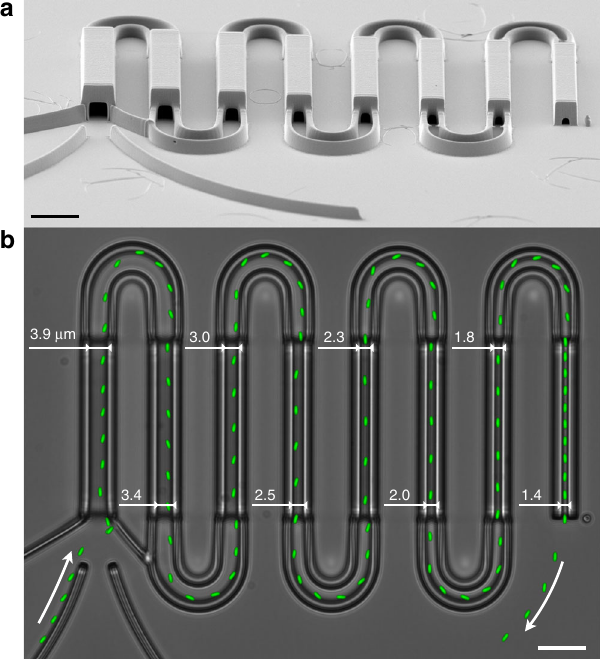
Fig. 1 E. coli cells swimming through a sequence of microtunnels of decreasing cross-section. a Scanning electron micrograph of the three- dimensional structure fabricated by two-photon polymerization. b Bacterial cells are imaged by fl uorescence microscopy, a representative cell is shown in green at constant time intervals of 0.3 s. A bright- fi eld microscopy image of the microtunnel structure is overlapped on the background. Scale bars 10 μ